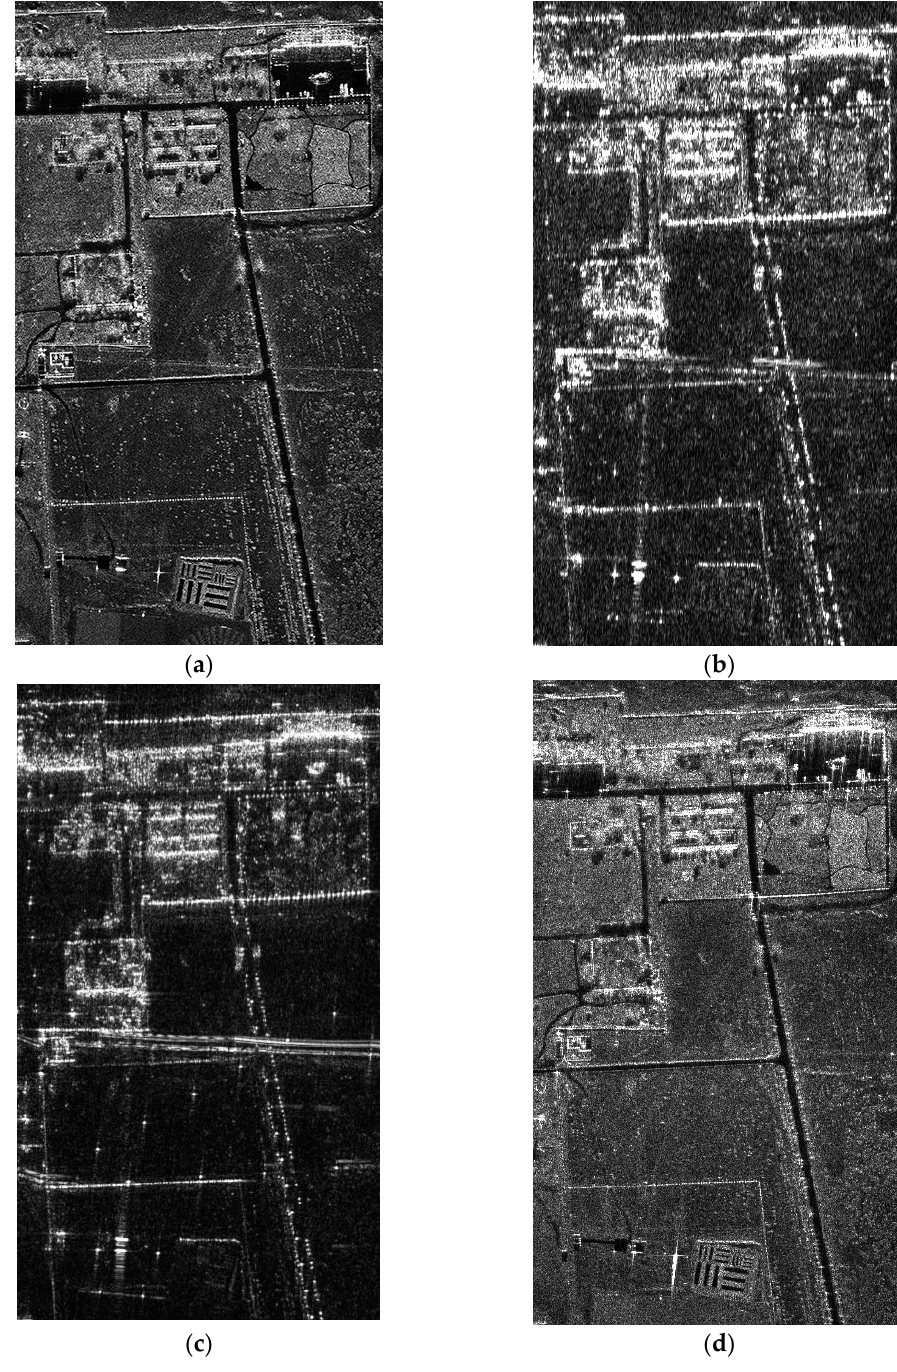
Figure 12. ( a ) C-band SAR. ( b ) L-band SAR. ( c ) P-band SAR. ( d ) X-band SAR. Similarly, all pictures are manually labeled, as shown in Figure 13, which contains four categories, pits, bare soil, buildings and roads. For these images, the classification results of the single band and the fusion method proposed in this paper are shown in Figures 14 and 15 and Table 2.